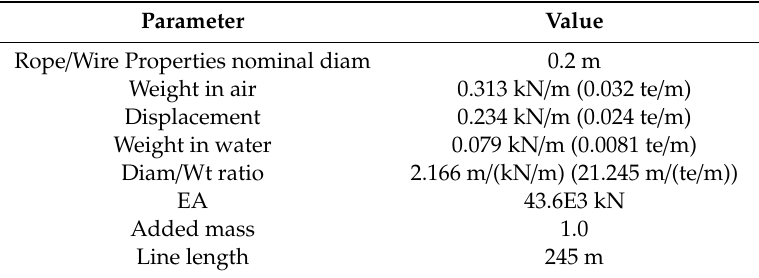
Table 5. Taut mooring line properties [43,44].